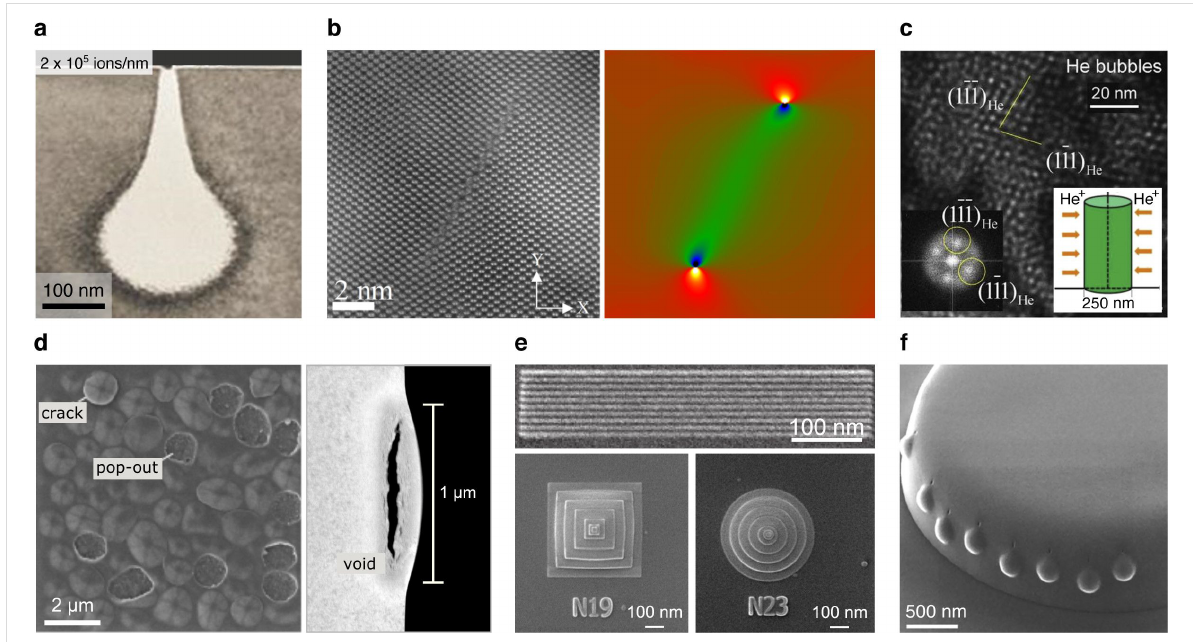
Figure 3: Effects of helium ion implantation studied with the HIM. (a) TEM cross-section analysis of the implant profile of 35 keV helium ions (line scan) in silicon for a dose above the amorphization threshold (the bright teardrop-shaped volume is the amorphized region). Adapted with permission from [75]. Copyright 2014 American Vacuum Society. (b) STEM image of a silicon crystal irradiated with helium ions in line-scan mode (left) with cor- responding strain field analysis (right). Adapted with permission from [76]. Copyright 2019 American Vacuum Society. (c) Helium gas-bubble